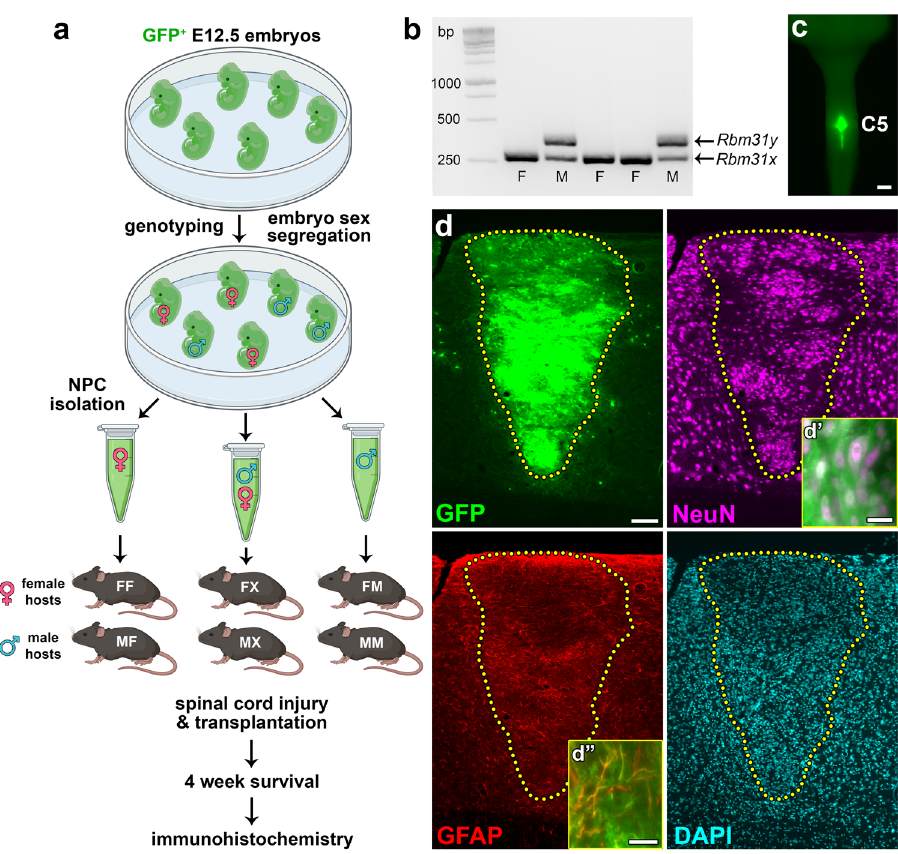
Fig.1|Transplantationofneuralprogenitorcellsofde fi nedbiologicalsexinto sitesofspinalcordinjury.a Experimentaldesign.GFP + E12.5mouseembryoswere genotyped todetermine biological sex. Spinalcords from male orfemale embryos were pooled and neural progenitor cells (NPCs) were isolated. Male and female mice received spinal cord injury followed by immediate transplantation of either 100% female NPCs, mixed 50/50 male/female NPCs, or 100% male NPCs. Survival time was 4weeks post-transplantation. FF female host, female graft, FX=female host, mixed graft, FM=female host, male graft, MF=male host, female graft, MX=male host, mixed graft, MM=male host, male graft. Image created with BioRender.com. b GeneticdeterminationofembryosexthroughPCRampli fi cation